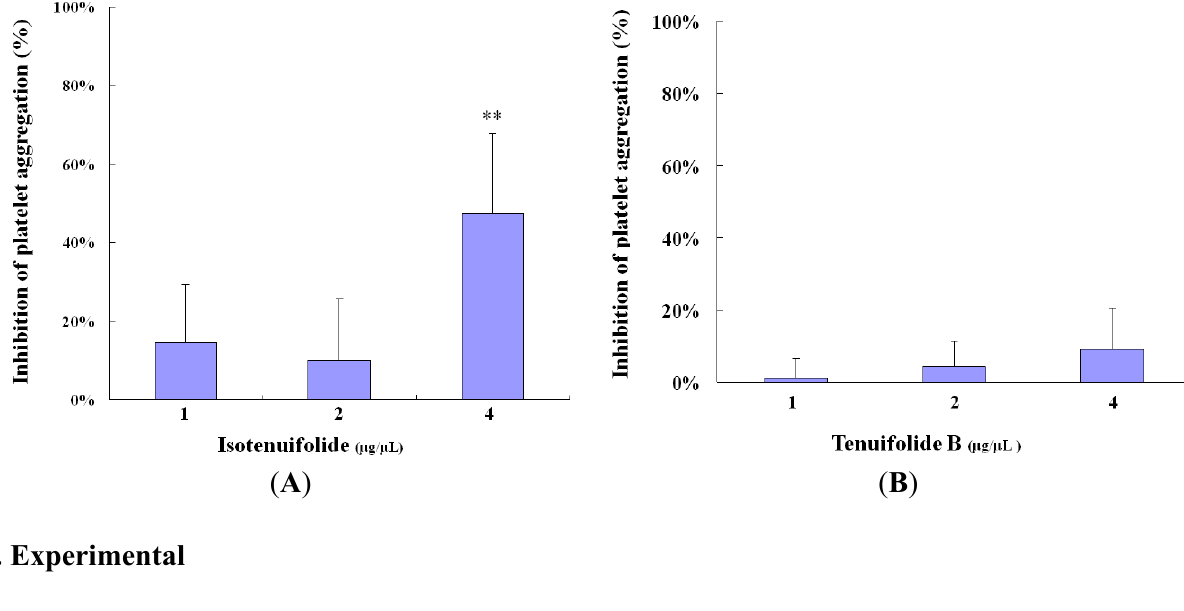
Figure 2. ( A ) Effects of isotenuifolide (1, 2 and 4 μ g/ μ L, n = 6) on platelet aggregation. ( B ) Effects of tenuifolide B (1, 2 and 4 μ g/ μ L, n = 6) on platelet aggregation. Plartelet-rich plasma (PRP) were preincubated with compounds or DMSO (0.4%, control) at 37 °C